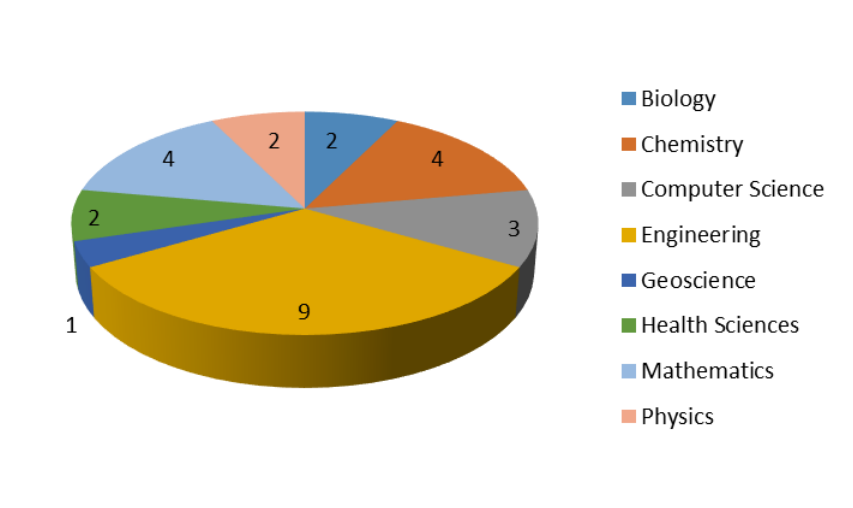
Figure 1. Distribution of faculty participants by STEM-related